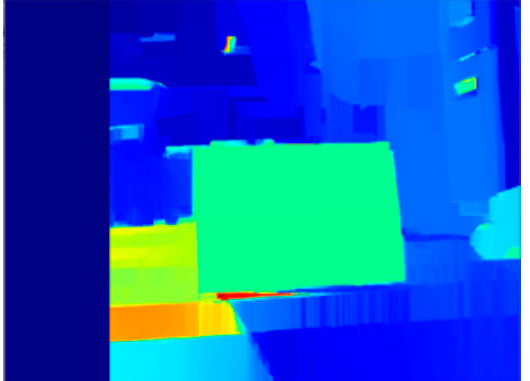
Figure 5. Effect after pseudo-color process, the deeper red (blue) is the closer